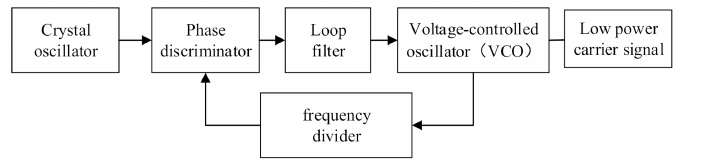
Figure 3. Composition of the PLL frequency synthesizer, where the reference frequency is generated by the crystal oscillator, and the low-power carrier signal is generated by the VCO; the frequency of the low-power carrier signal is controlled by the phase discriminator.